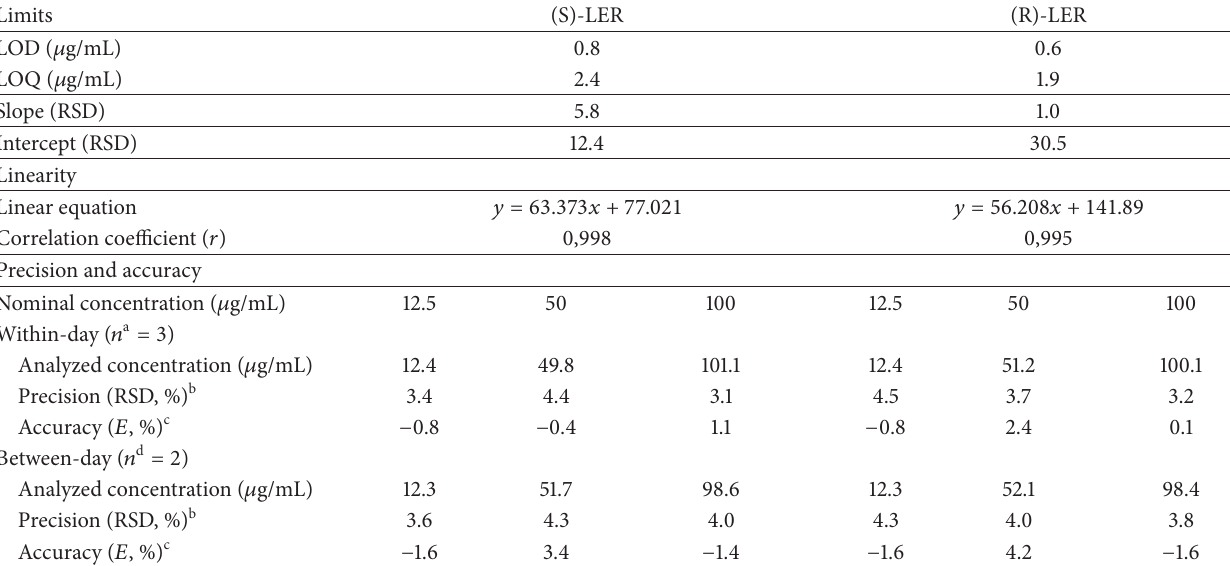
Table 5: Linearity, LOD and LOQ, precision, and accuracy of the method for LER enantiomer